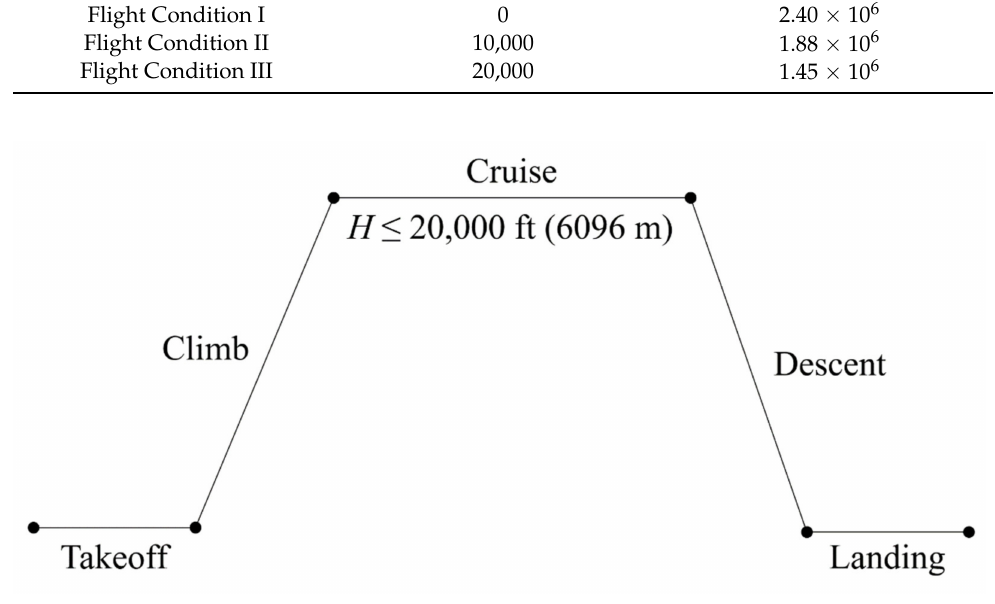
Figure 6. Schematic of the flight regimes of